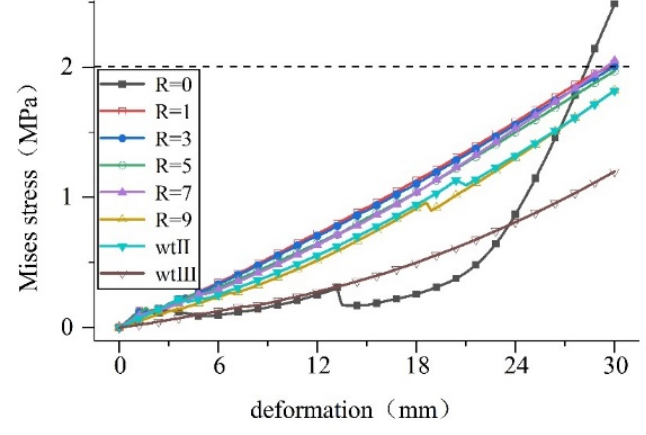
Figure 21. Settlement deformation stress on waterstops of various size.